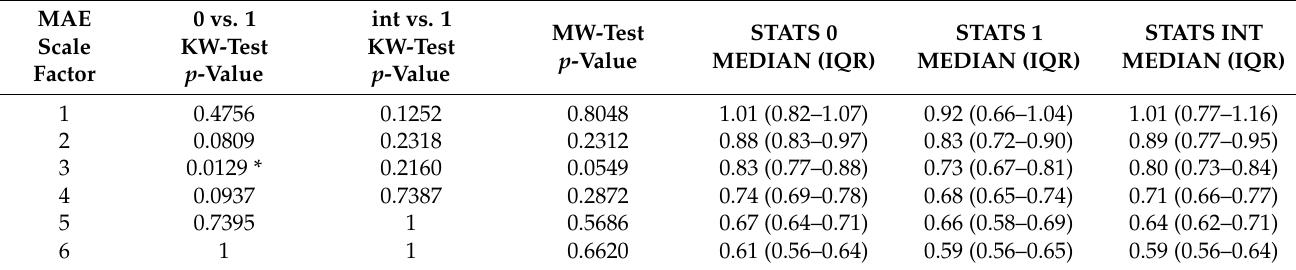
Table 1. Multiscale Approximate Entropy—Results of the test described in Section 2.6. The median and IQR values are reported for the three groups considered (0, 1, and int). Star (*) denotes statistically significant results.